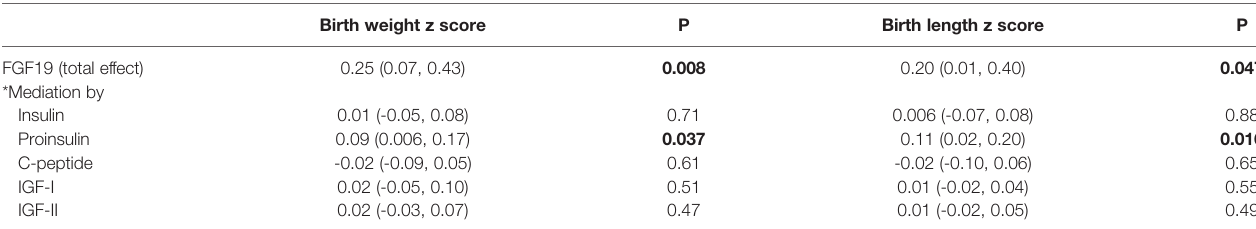
TABLE 5 | Mediation analyses in the associations of cord blood FGF19 with fetal growth (birth weight, birth length) in female newborns (n=140).